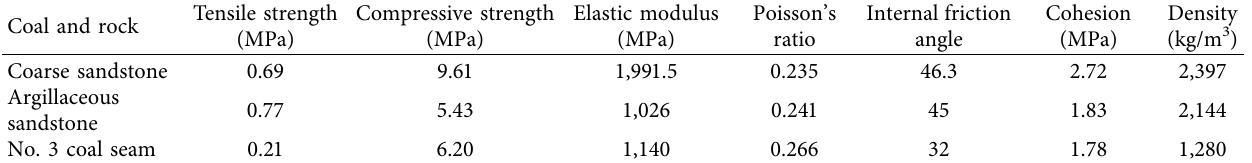
Table 1: Numerical calculation of mechanical parameters of the coal and